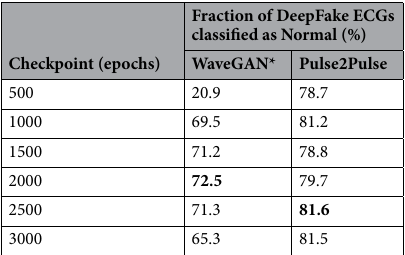
Table 1. Quantitative difference between WaveGAN* and Pulse2Pulse GAN in the initial training for determining the optimal network and optimal number of epochs. The best values are bolded for each GAN.